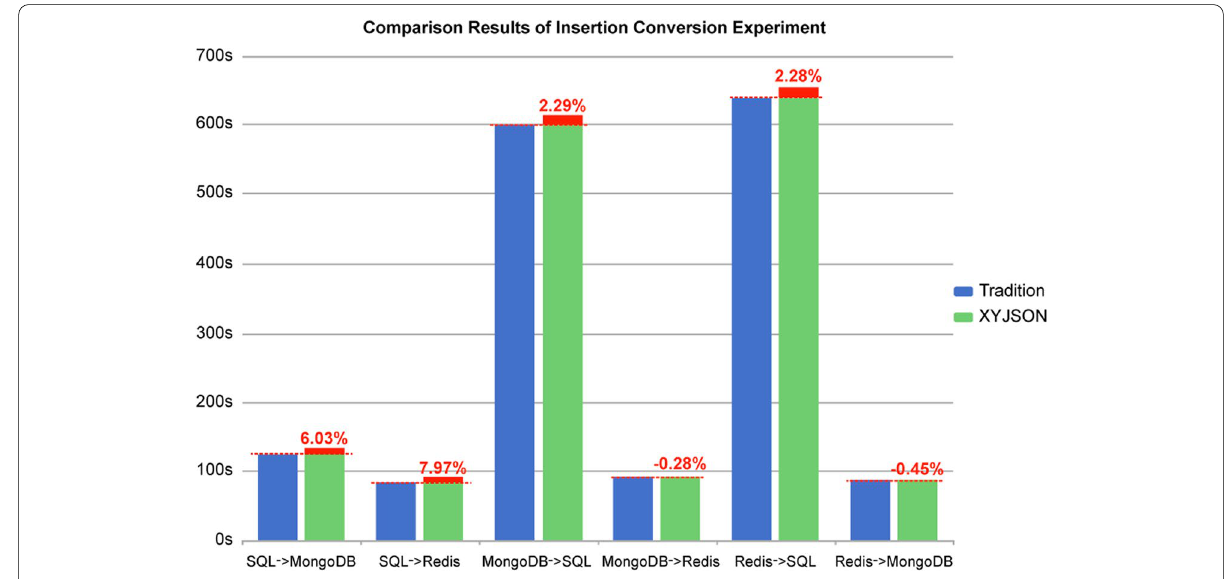
Fig. 6 Comparison results of insertion conversion